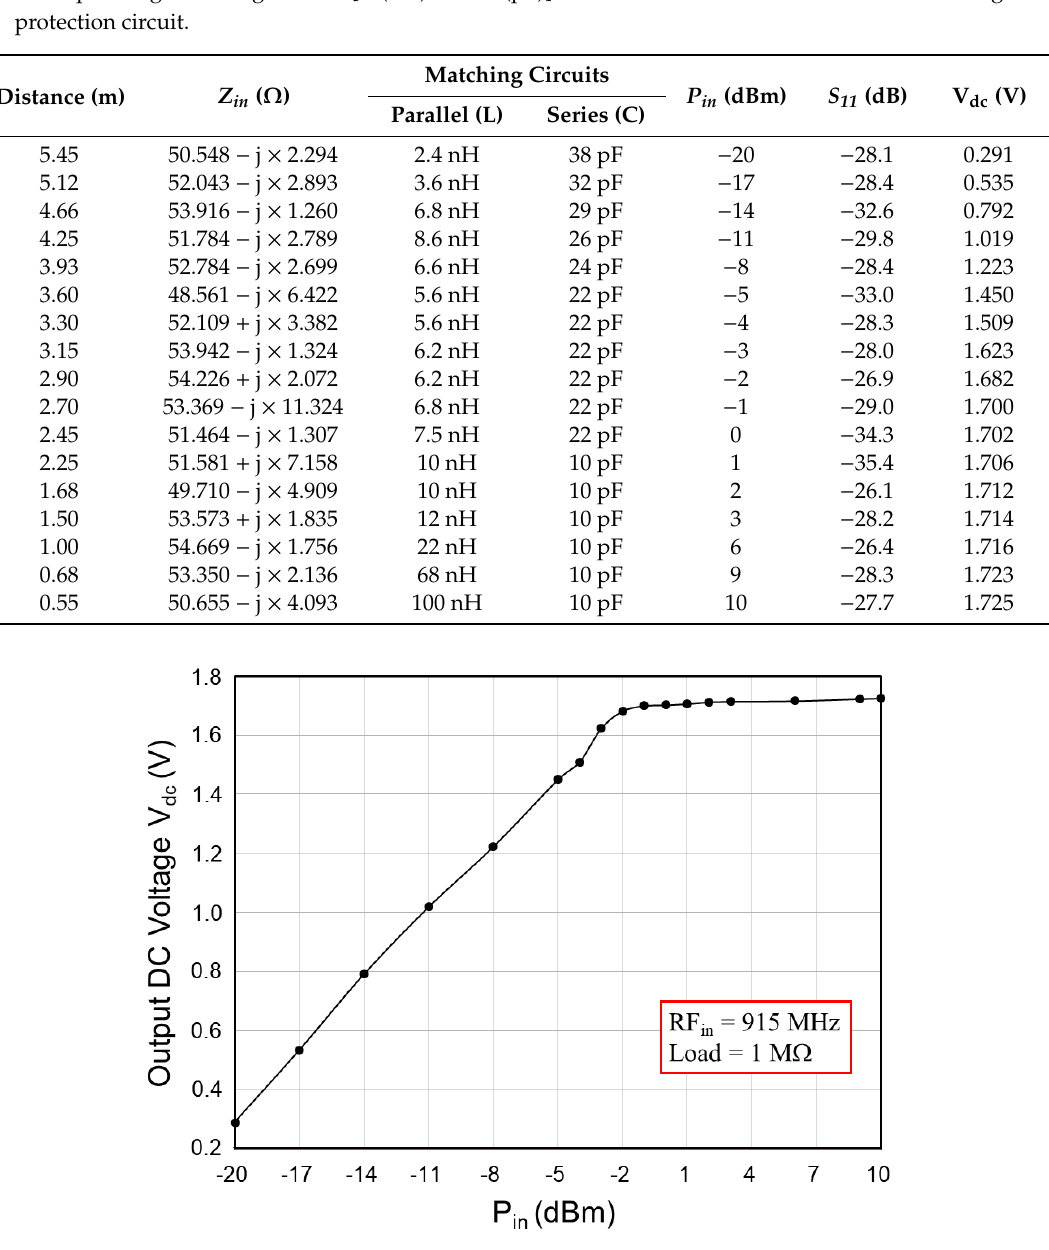
Figure 21. Measured DC output voltages of the RF-DC rectifier with over-voltage protection with respect to the input power. Table 3. Measured input power P in (dBm), input return loss S 11 (dB), and output DC voltage V dc (V) with respect to distance (m) between the transmitter and test PCB, input impedance Z in ( Ω ) and its corresponding matching circuits [L (nH) and C (pF)] for the RF-DC rectifier with the over-voltage protection circuit.